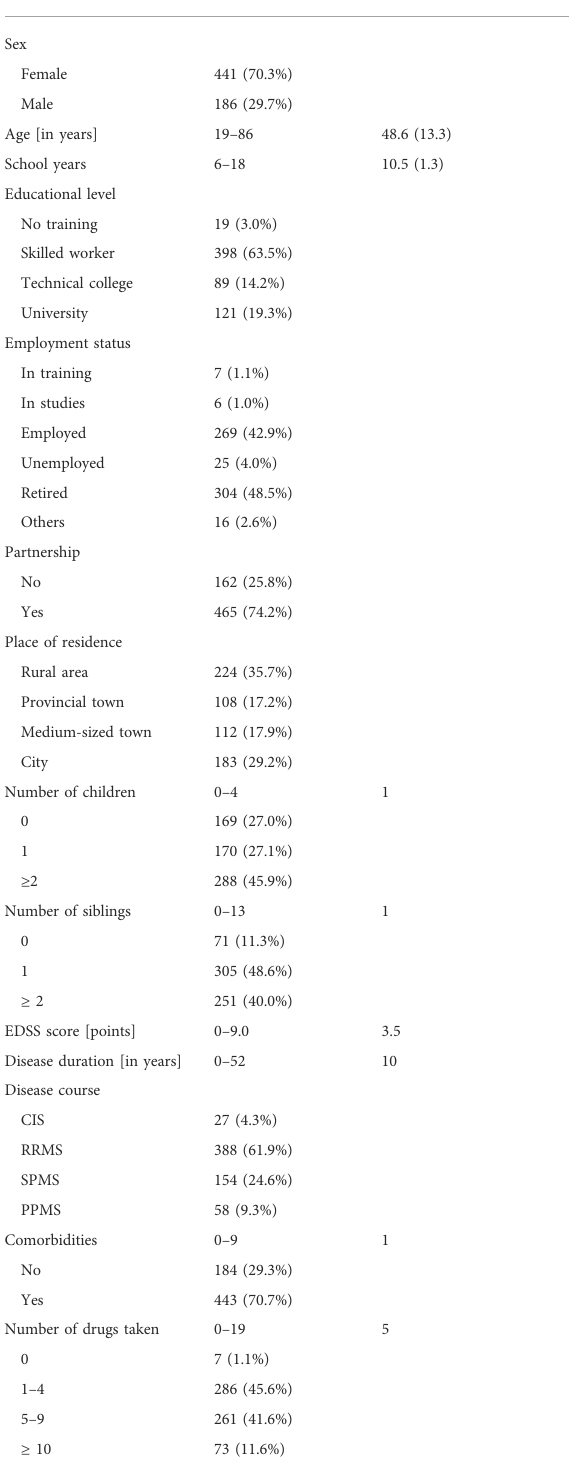
TABLE 1 Sociodemographic, clinical and medication data of the patient cohort ( N =